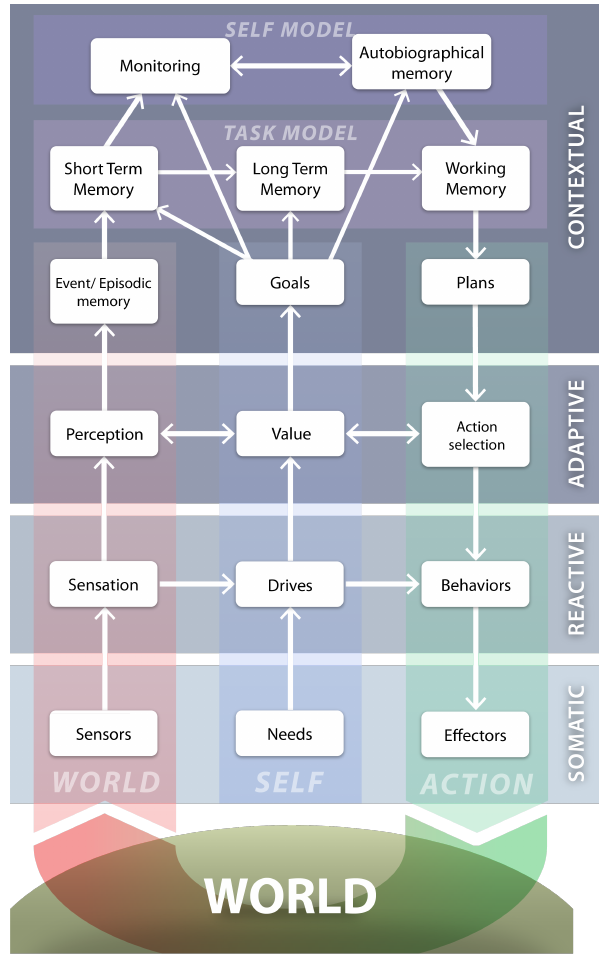
Figure 1: The Distributed Adaptive Control (DAC) theory of mind and brain architecture graphically represented. DAC proposes that the mind is organized in layered control structures (Somatic, Reactive, Adaptive and Contextual) tightly coupled together. Across layers there is a columnar organization regarding processing the states of the world (left, red, exteroception), the self (middle, blue, inte- roception) and action (right, green) that mediates between the first two. See text for further information. Image adapted from